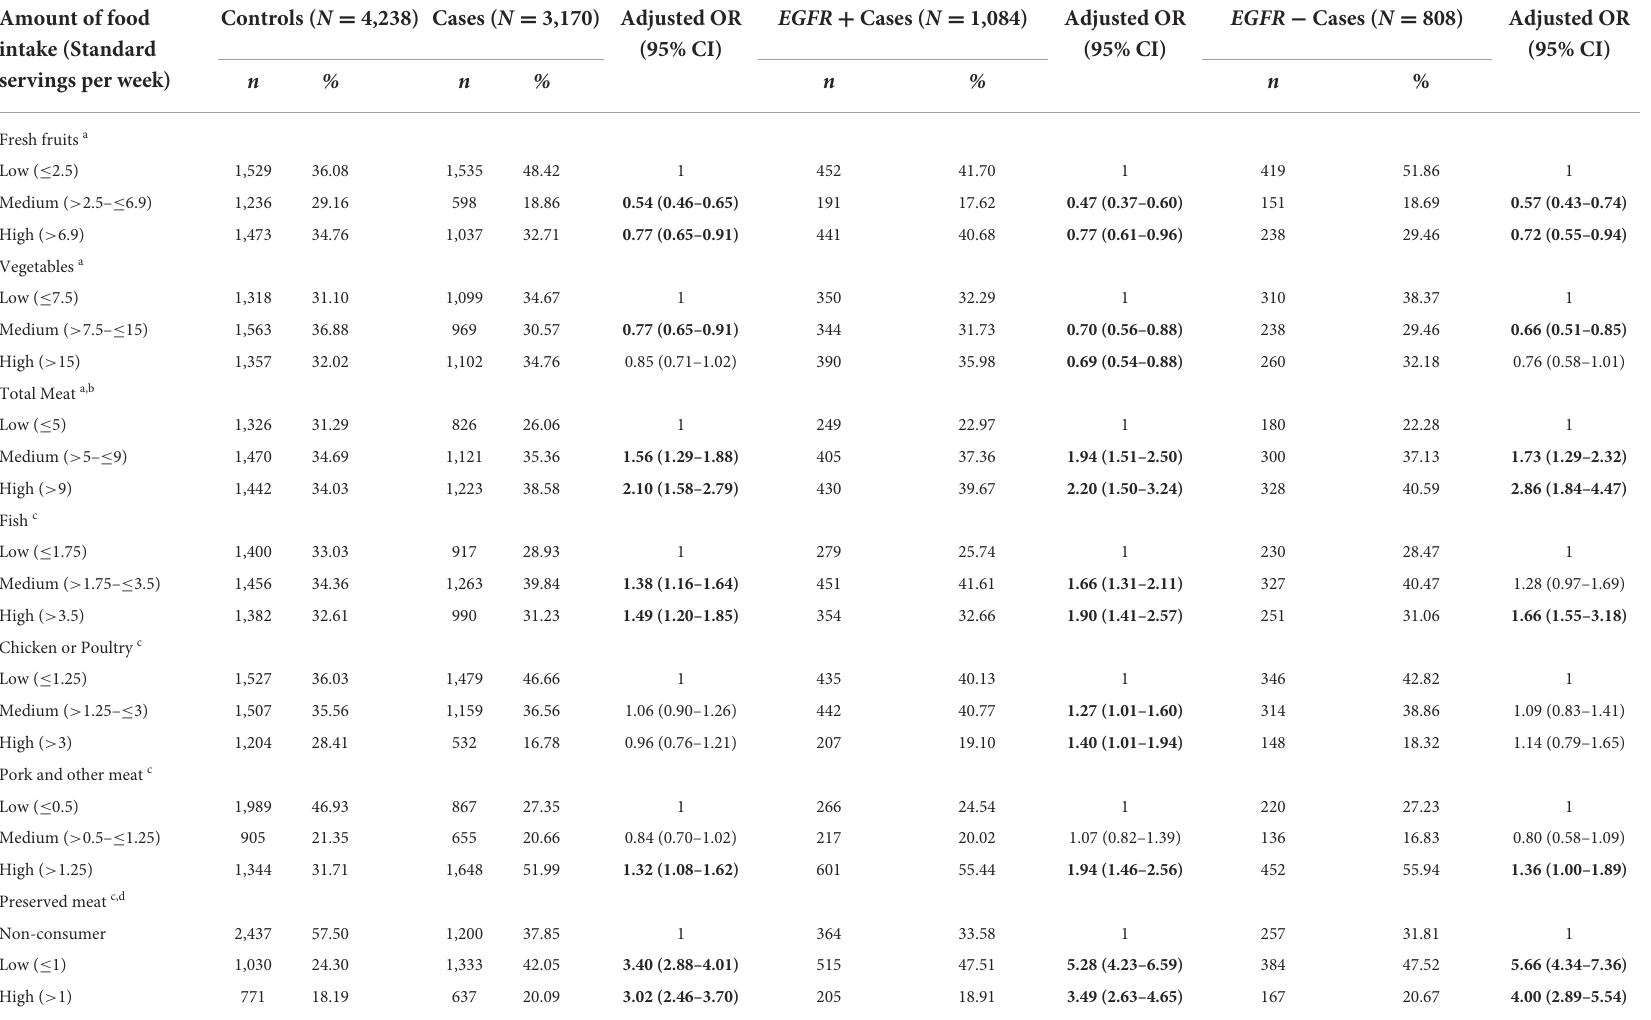
TABLE 2 Association between consumption of fruits, vegetables, and meat with risk of lung cancer subtypes. Amount of